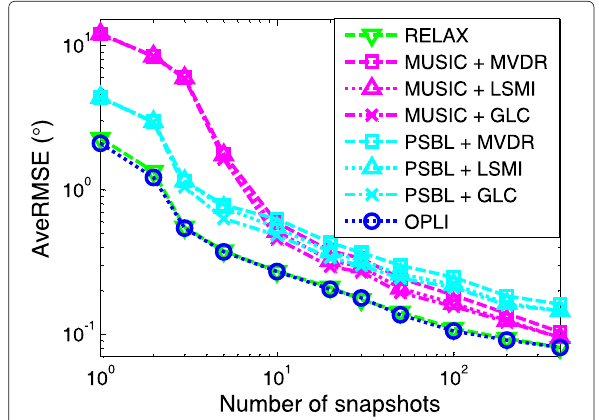
Fig. 8 AveRMSE versus the number of